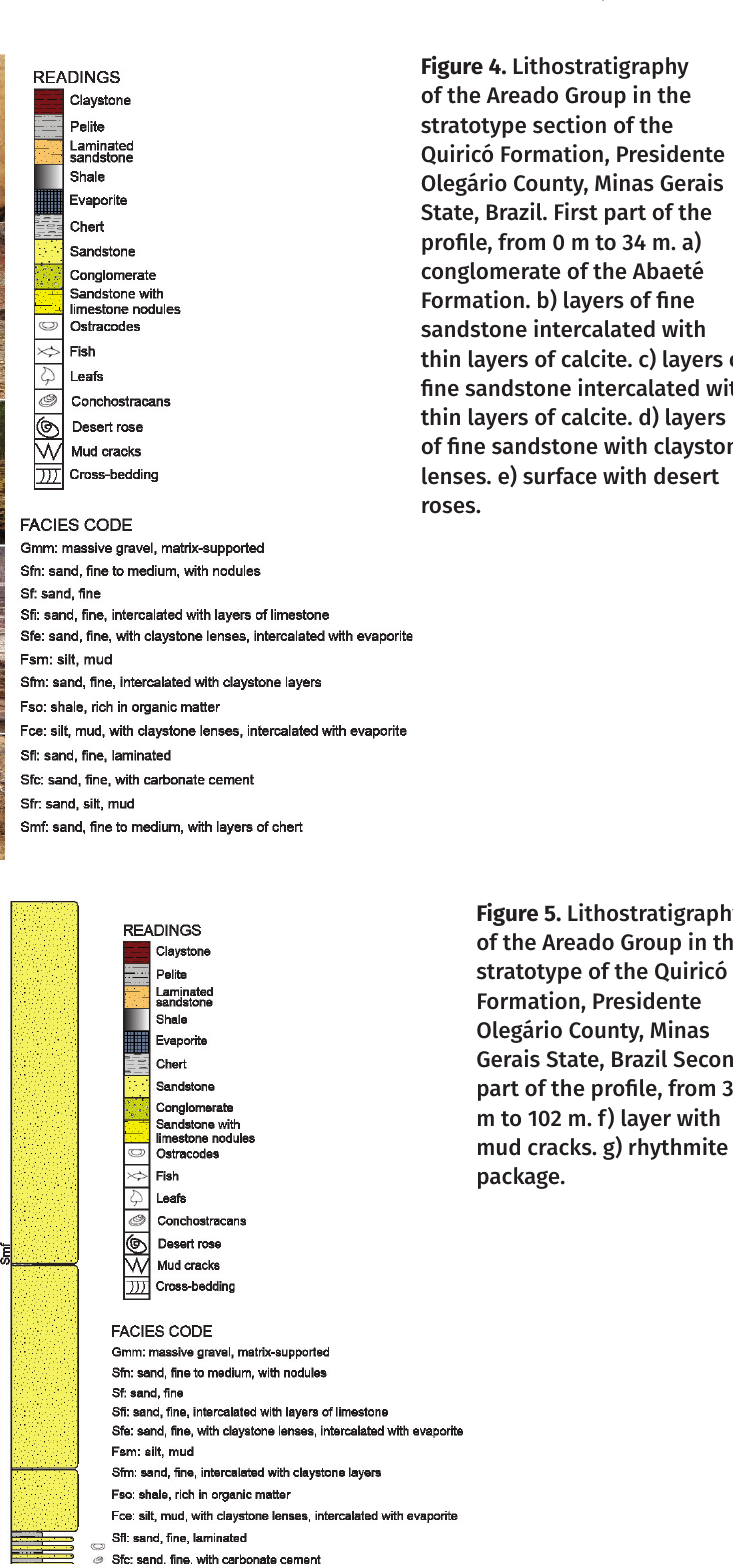
Figure 5. Lithostratigraphy of the Areado Group in the stratotype of the Quiricó Formation, Presidente Olegário County, Minas Gerais State, Brazil Second part of the profile, from 34 m to 102 m. f) layer with mud cracks. g) rhythmite package.